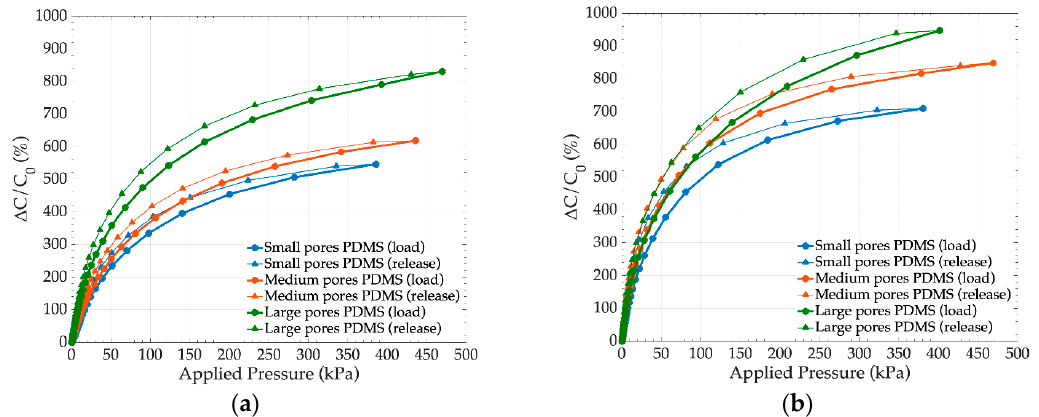
Figure 7. Variation of the capacitance according to the applied pressure, depending on the pore size for ( a ) 4:1 and ( b ) 6:1 PDMS foams ( d 0 = 5 mm ± 0.5 mm).